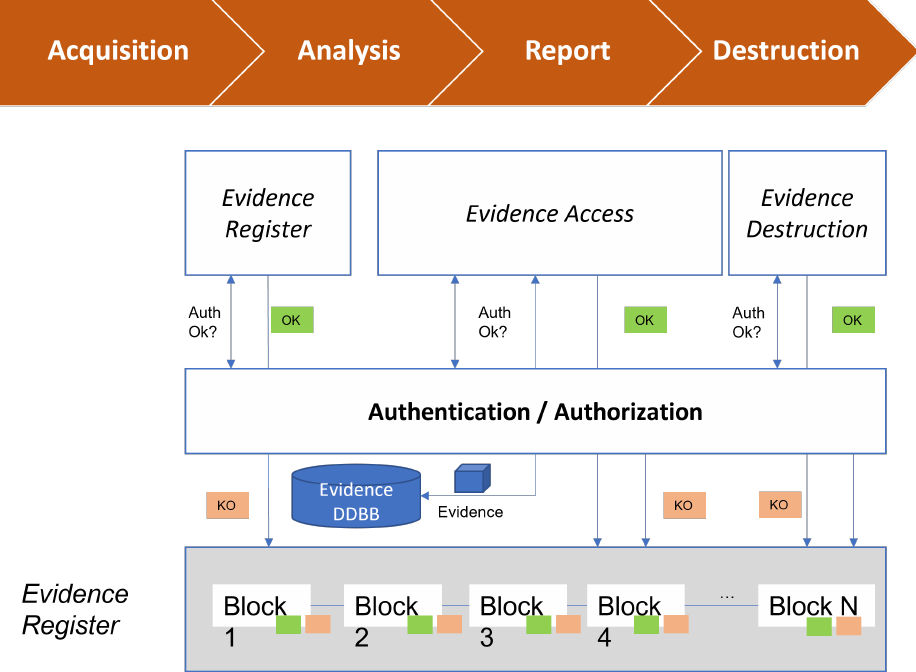
Figure 2. Proposed CoC process